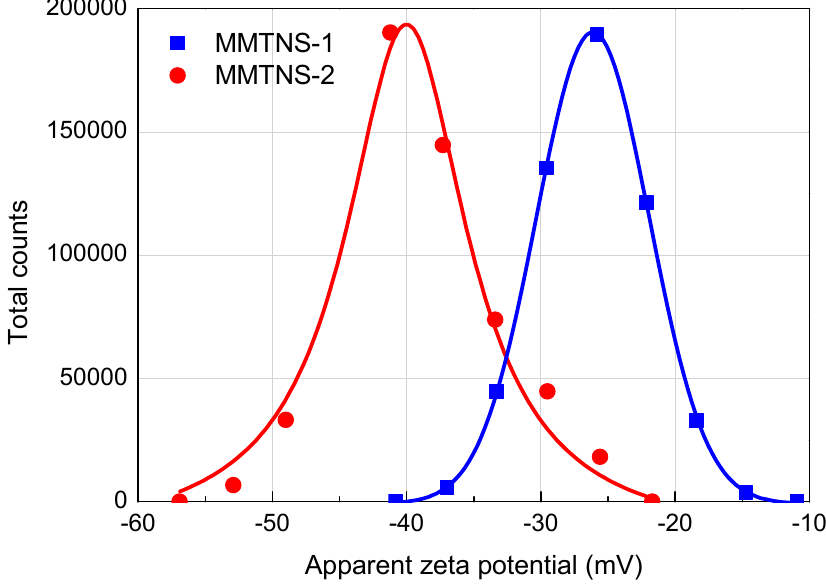
Figure 9. Zeta potential distribution of MMTNS-1 and MMTNS-2 at pH 9.